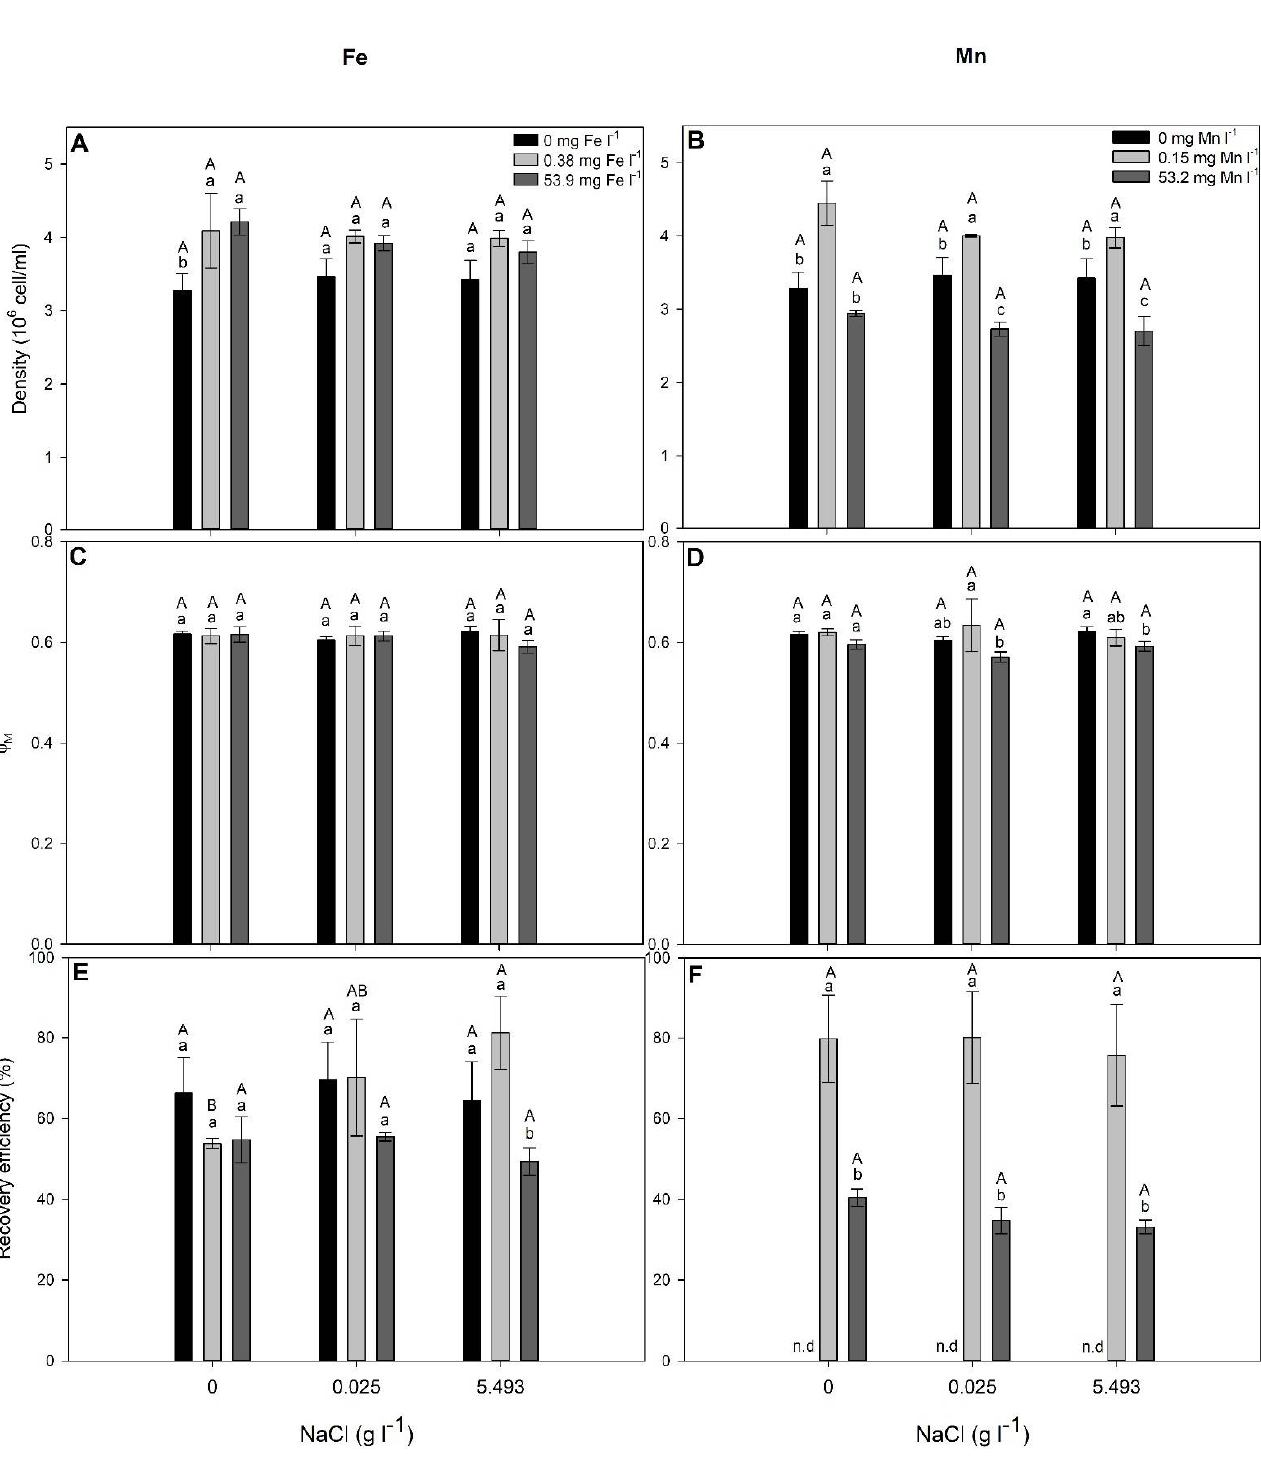
Figure 4. Cell density ( A , B ), the maximal PSII photochemical yield ( Φ M ) ( C , D ) and the Fe- and Mn-recovery efficiency ( E , F ) in Chlorococcum infusionum exposed to increased concentrations of NaCl (g L − 1 ) with addition of 0, 0.38, and 15.2 mg Fe L − 1 or 0, 0.15, and 2.5 mg Mn L − 1 . Bars represent means ± SD of three replicates. Lowercase letters indicate significant differences among Fe or Mn concentrations within the same NaCl addition, while uppercase letters indicate significant differences between NaCl concentrations within the same Fe or Mn addition, by the post hoc Tukey test (considering p <